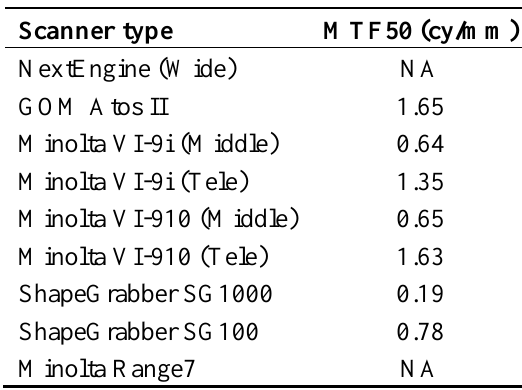
Table 9. Values of MTF50 for the different scanners analyzed in the paper, whose spectra are reported in Figure